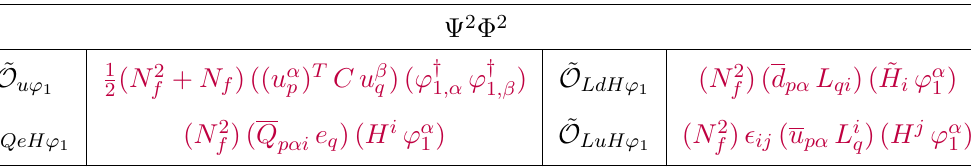
Table 22 . SM extended by Lepto-Quark ( ϕ 1 ): additional operators of dimension 5. Here i, j and α, β are the SU(2) and SU(3) indices respectively. p, q = 1 , 2 , · · · , N f are the flavour indices. All the operators of this class violate lepton